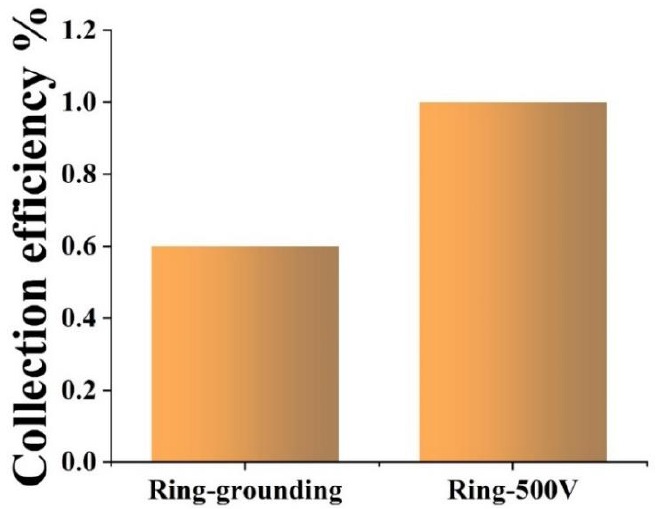
Figure 9. Collection efficiency of particles with different applied voltages on the nozzle and ring electrode.